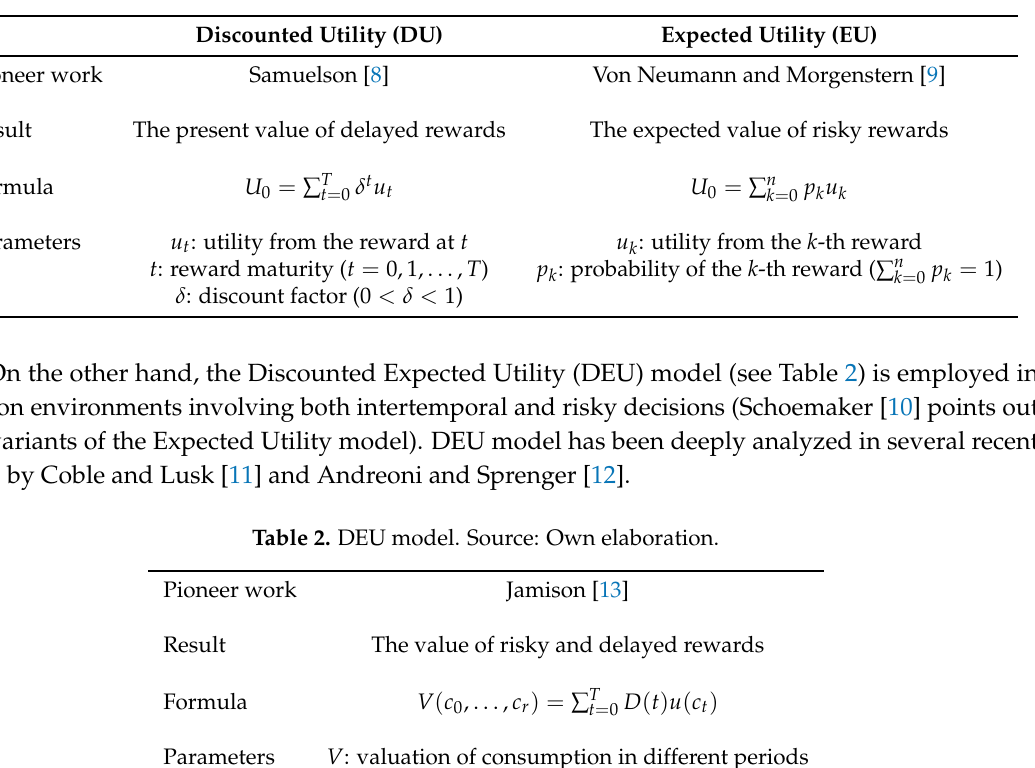
Table 1. Classical models to obtain the utility value. Source: Own elaboration.